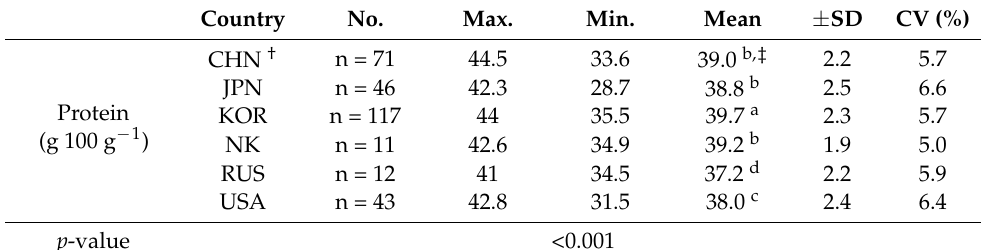
Table 2. Maximum, minimum and mean value of protein contents according to the collected country in 300 soybean